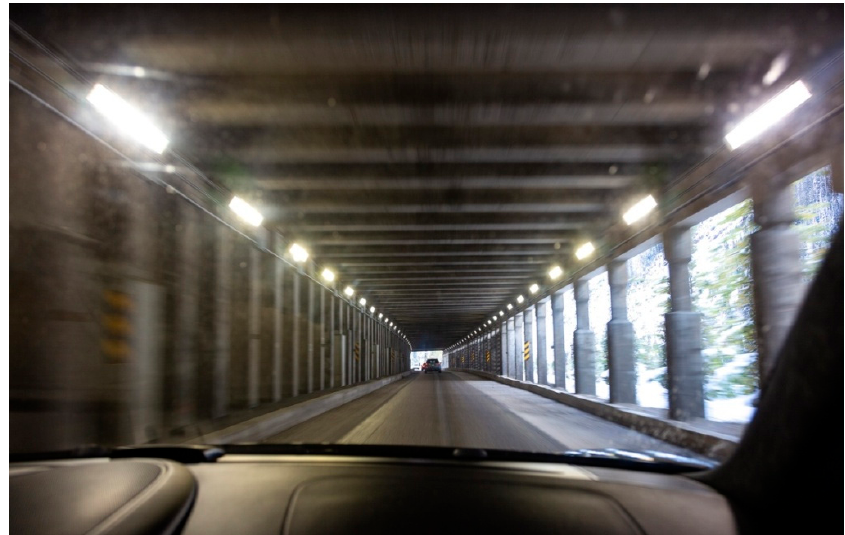
Figure 2. Lateral columns to use natural light in an almost open tunnel (Spain) (adapted from [20]).